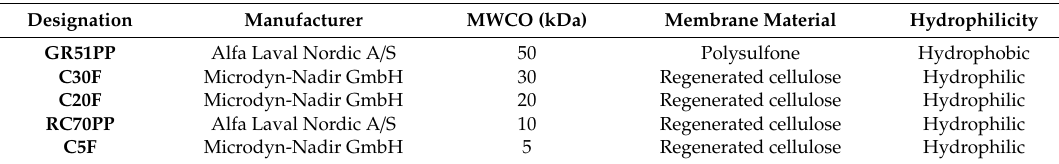
Table 1. List of membranes used in the study, where MWCO denotes molecular weight cut-o ff